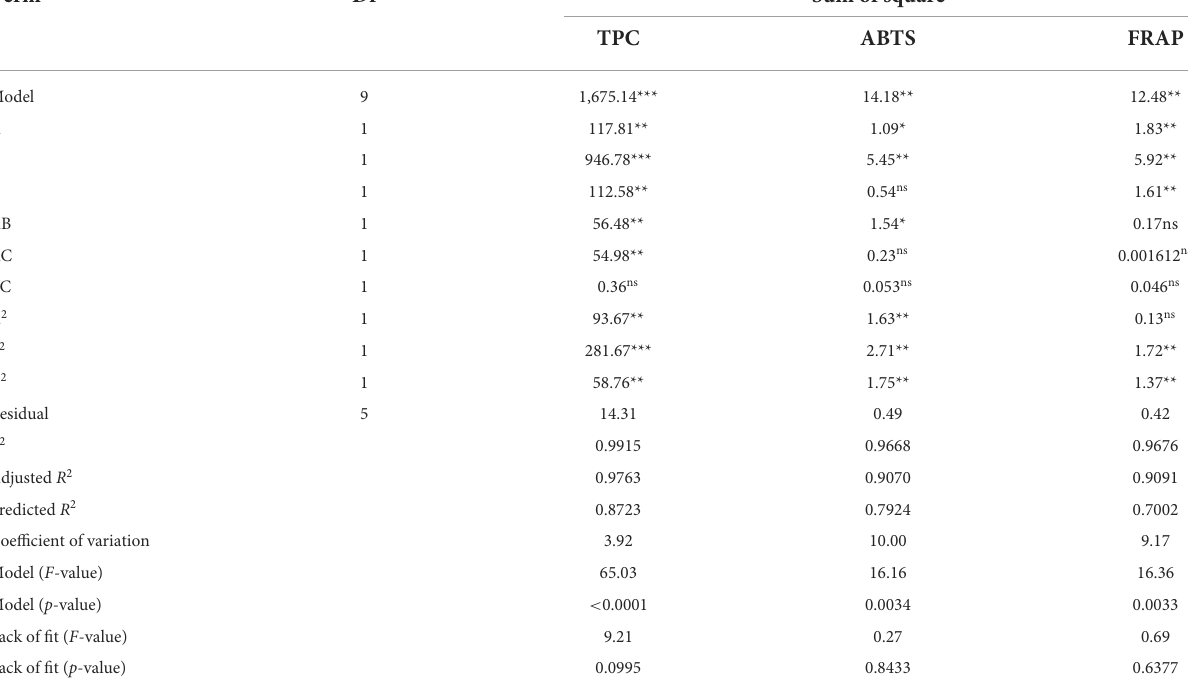
TABLE 3 ANOVA for response surface quadratic